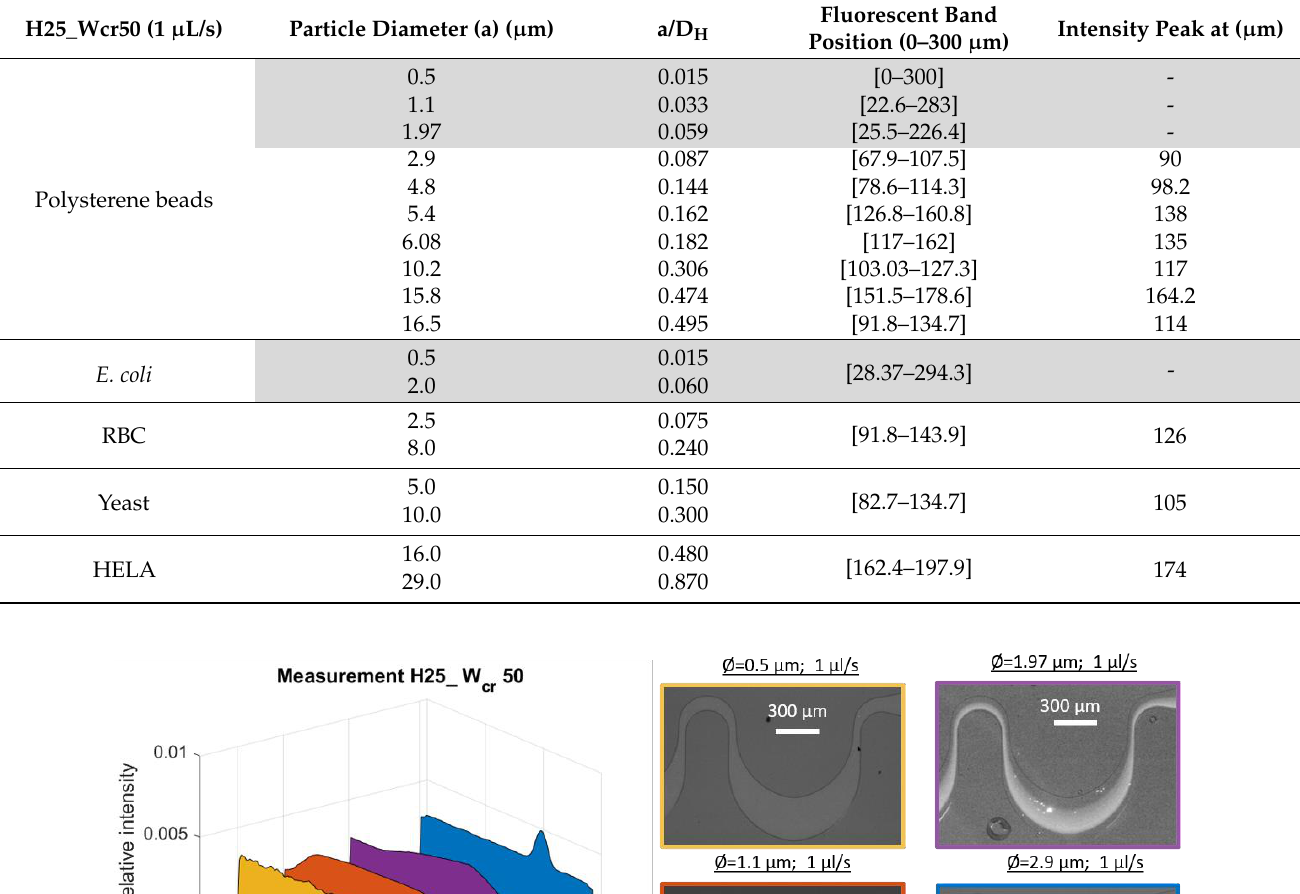
Table 3. The a/D H value calculated from the particle and channel size ratio characterized the criteria of size-dependent lateral focusing in the case different biological targets and model beads. The experimental focusing position (or concentration range) is also summarized. Gray background marks the cases where lateral focusing nor theoretically nether experimentally can occur in the microfluidic channel.